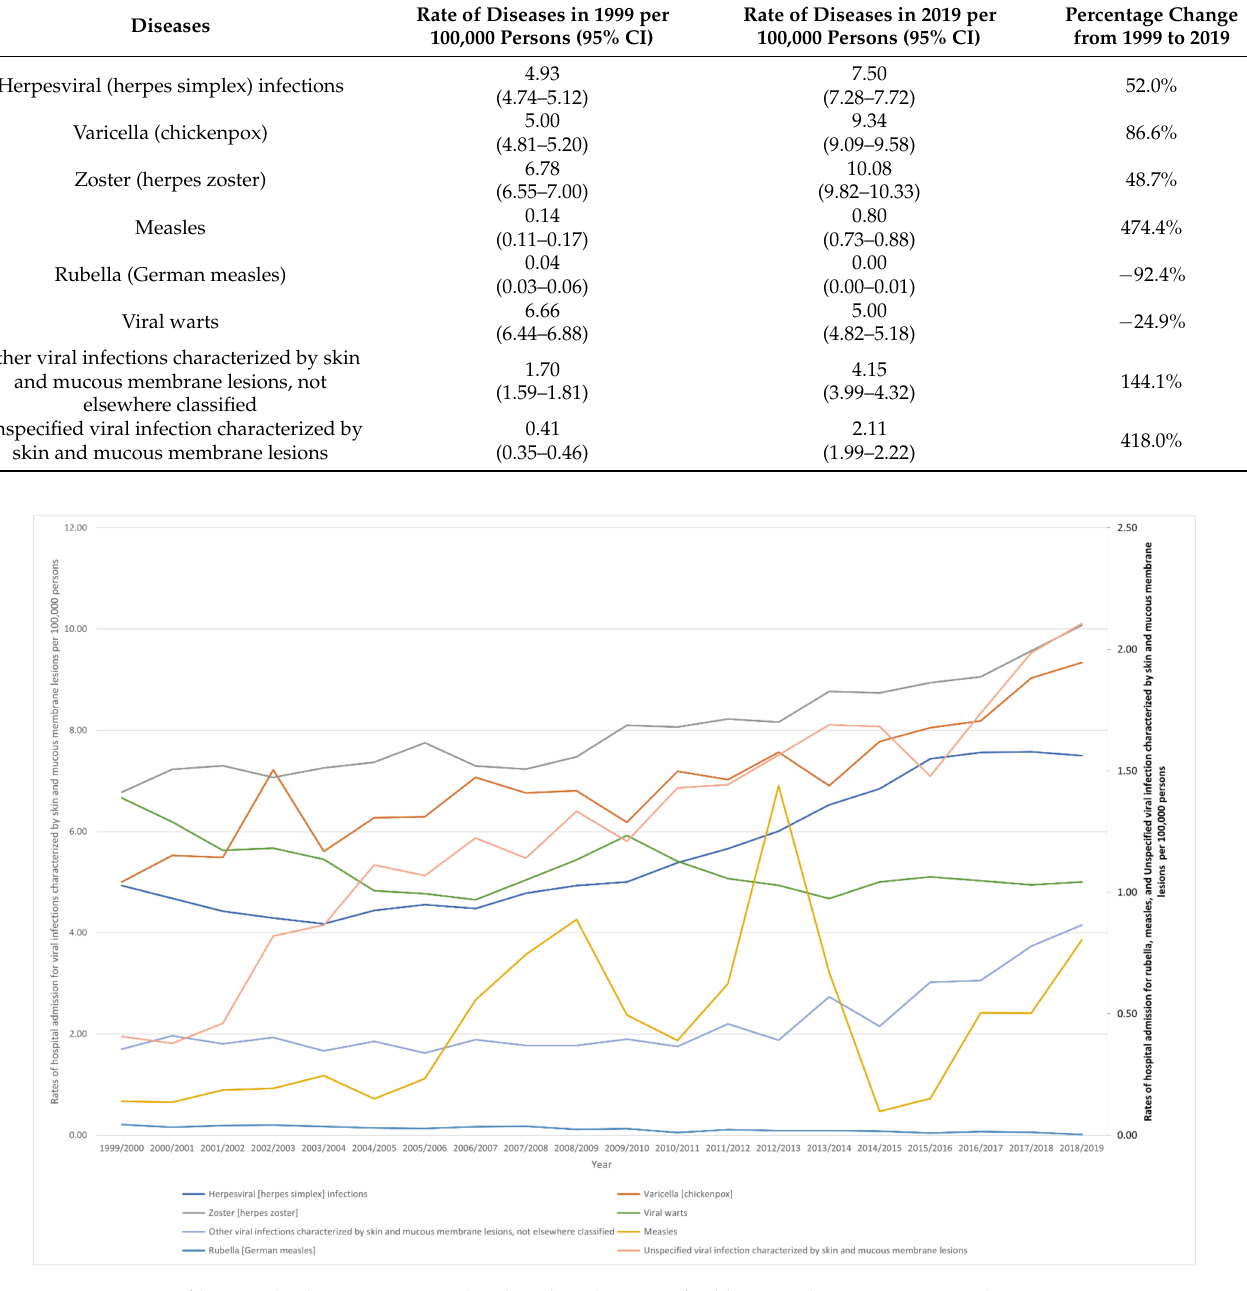
Figure 1. Rates of hospital admission in England and Wales stratified by type between 1999 and 2019. Concerning age group variation for viral infections characterized by skin and mucous membrane lesions hospital admission, during